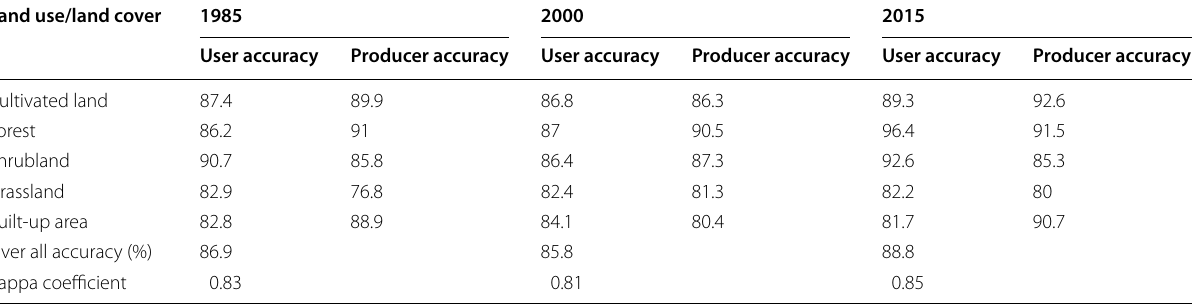
Table 3 Accuracy assessment of the 1985, 2000 and 2015 classified images Land use/land